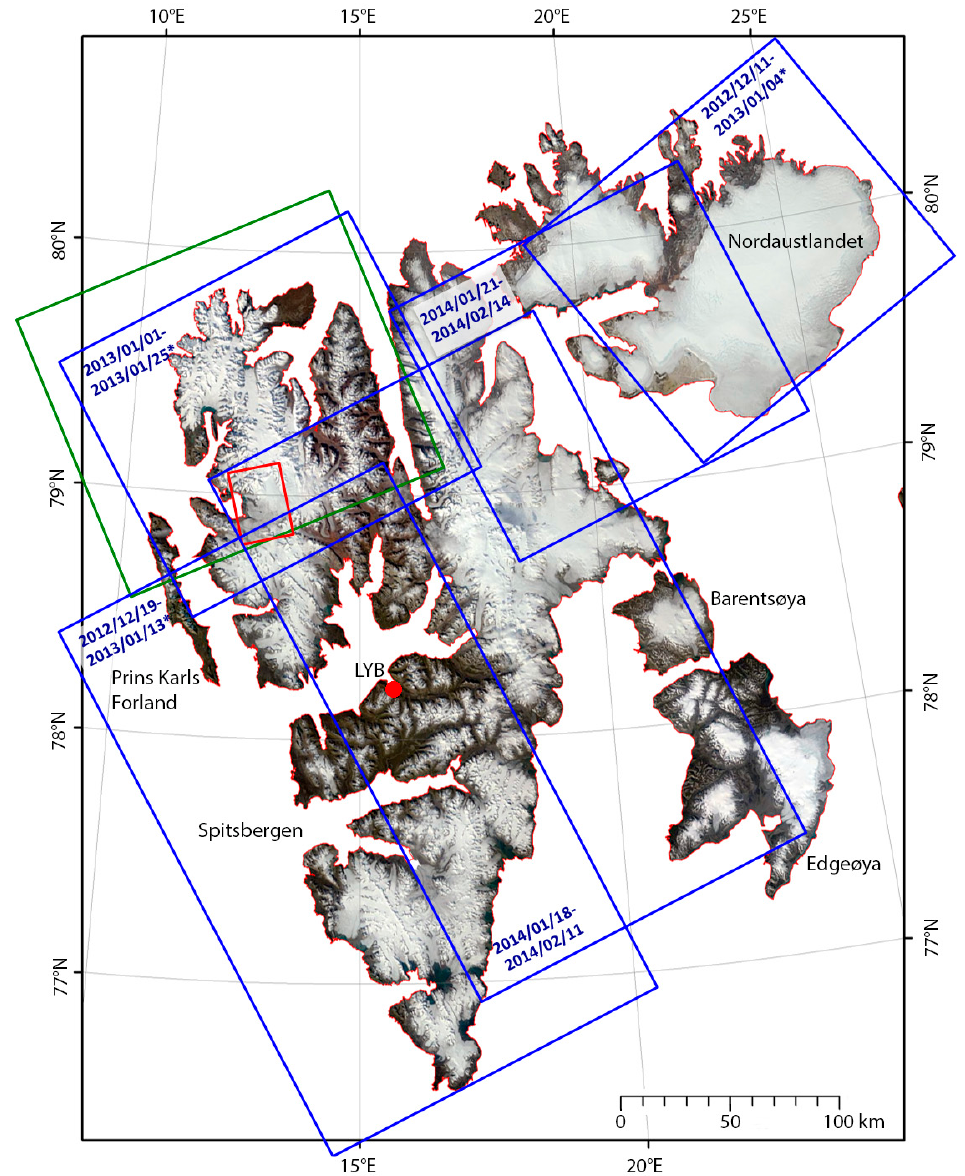
Figure 1. Image extents of Radarsat-2 image pairs utilized in this study (green outlines denote Radarsat-2 Wide imagery acquired 25 December 2012 and 18 January 2013; red outlines denote Radarsat-2 Ultrafine imagery acquired 3 January 2013 and 20 February 2013; blue outlines denote Radarsat-2 Wide Fine imagery with acquisition dates). Names of the main islands and the location of Longyearbyen (LYB) are also marked. Background image: MODIS Terra RGB composite.